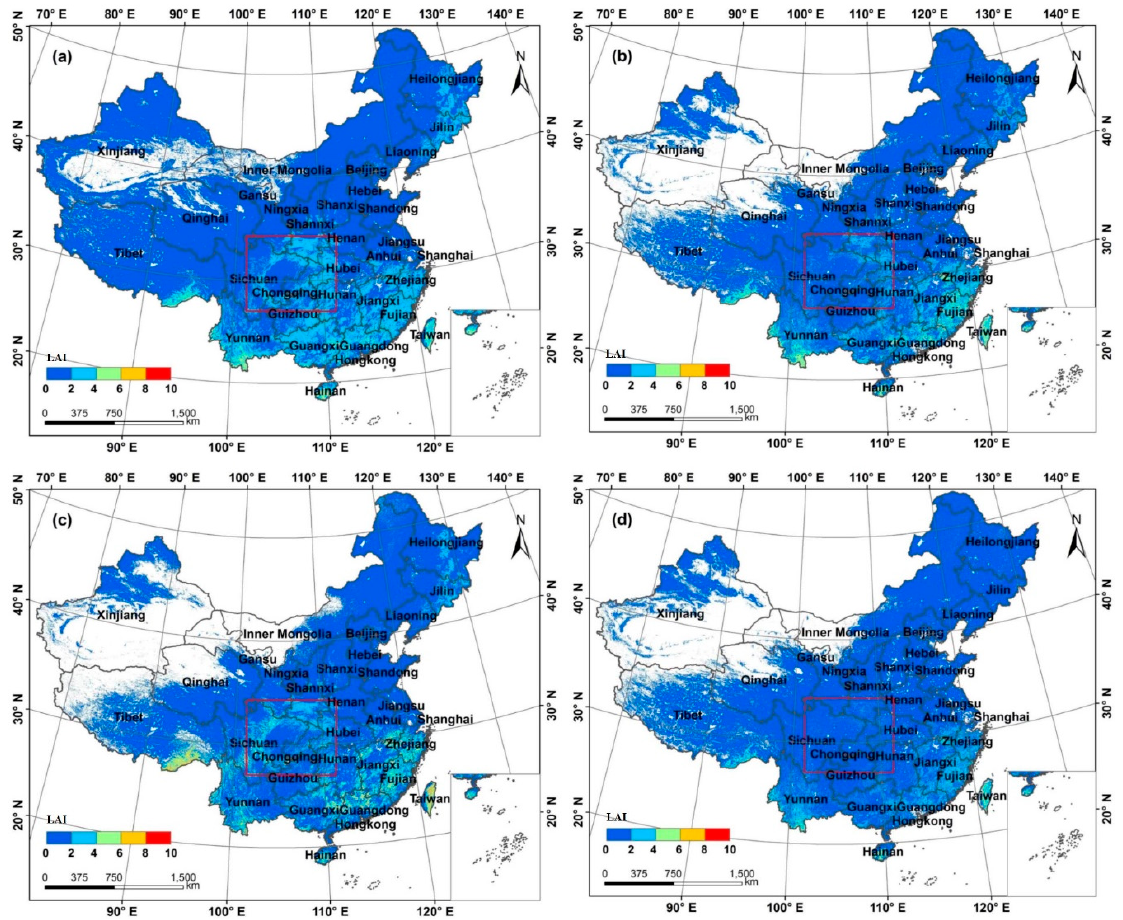
Figure 5. Spatial distributions of four LAI climatologies: ( a ) GLASS ( b ) GLOBALBNU; ( c ) GLOBMAP; ( d ) MODIS.